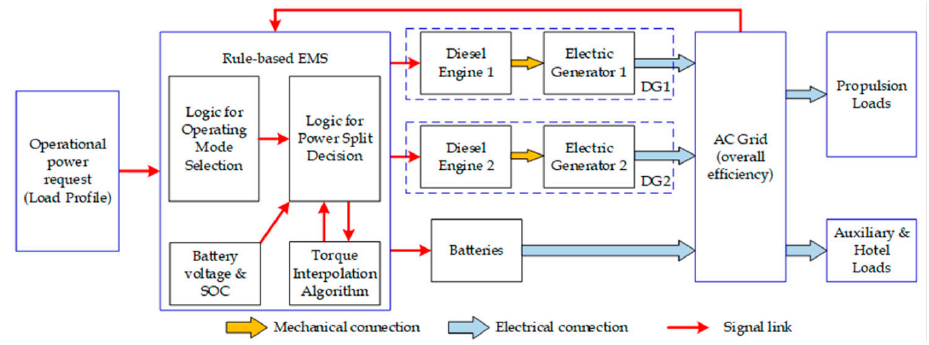
Figure 6. General EMS control diagram of the targeted AC